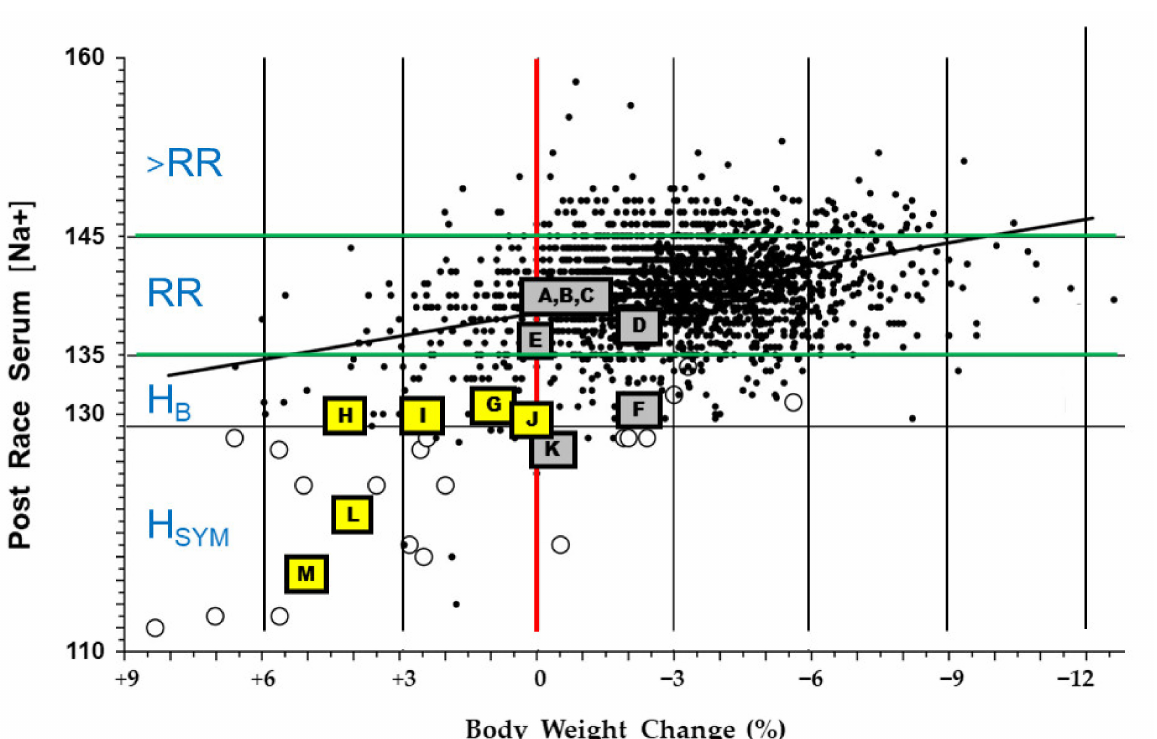
Figure 2. The relationship between body weight change (%) and serum Na + after 4.0–13.3 h of exercise ( n = 2135) as modified from [20]. Solid circles ( • ) represent asymptomatic marathon runners and Ironman triathletes. Open circles ( depict athletes with severe symptoms including hyponatremic encephalopathy (central nervous system dysfunction due to brain swelling). Horizontal zone abbreviations: >RR, serum Na + concentration above resting normal; RR, the laboratory reference range for healthy adults (green horizontal boundaries); H B , biochemical hyponatremia which involves few or no symptoms; H SYM , symptomatic hyponatremia. Symbols A–M were overlaid by the present author (see details below in Section 3.2.1). Gray highlighted symbols depict individuals with fluid intake rates of ≤ 700 mL/h and body mass losses of 0.1 to 2.6%. Yellow highlighted squares indicate exertional hyponatremia cases (each n = 1) with fluid intake rates ranging from 733–2061 L/h and body mass increases of +0.1 to +5.0%. Reprinted via the PNAS Open Access option from